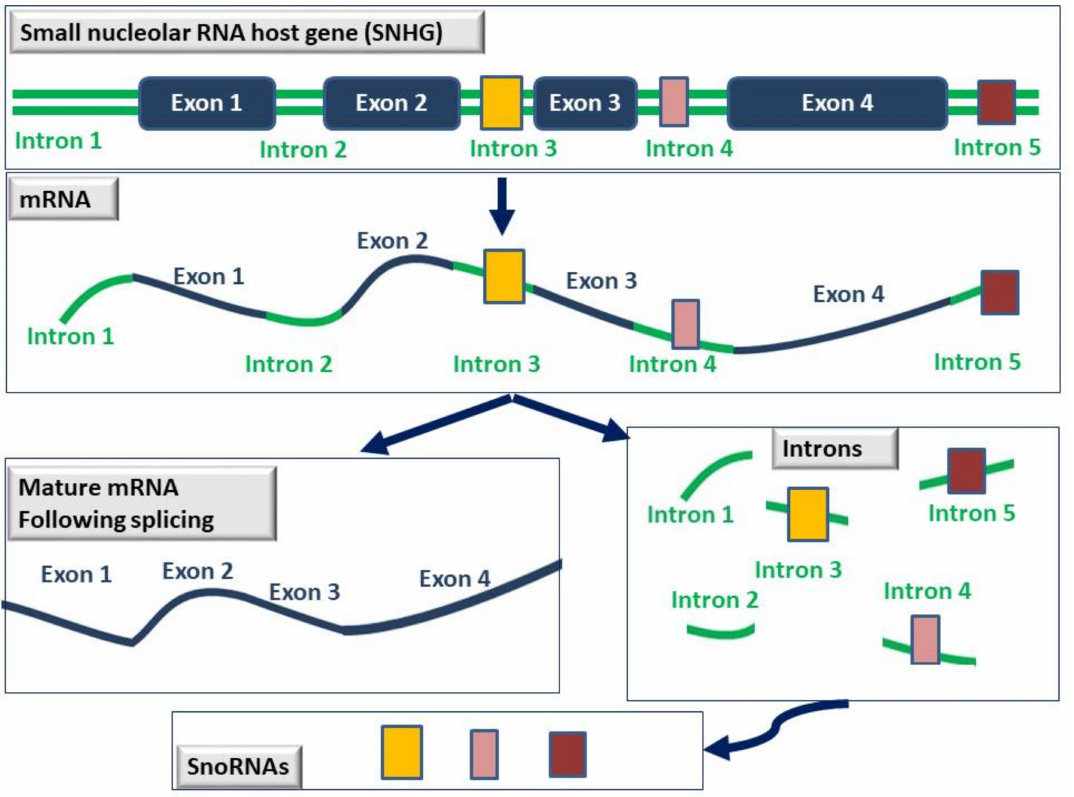
Figure 3. Schematic representation of the process by which snoRNAs are generated. SnoRNAs (depicted as yellow, pink, or brown boxes) are usually hosted within the intron sequences of genes known as small nucleolar RNA host genes (SNHGs). Following splicing, exons are connected together to generate the mature mRNA, and the introns are further processed into snoRNAs that are now fully functional in the